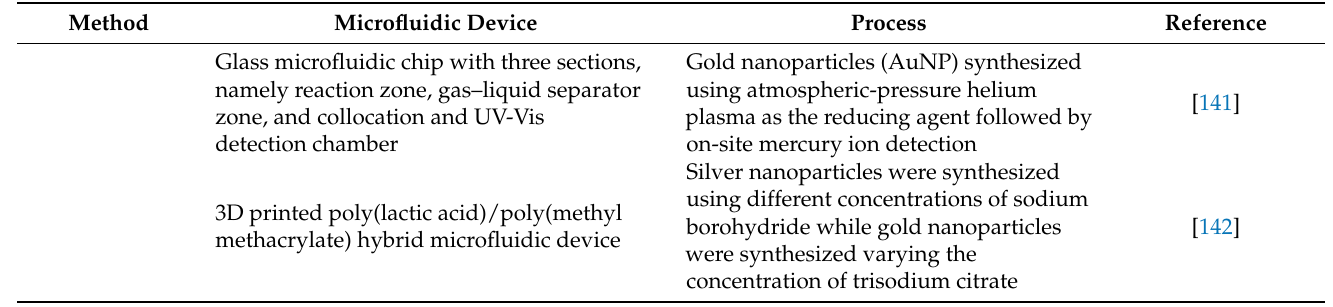
Table 2. Examples of usage of spectroscopic methods for monitoring processes in microfluidic devices.